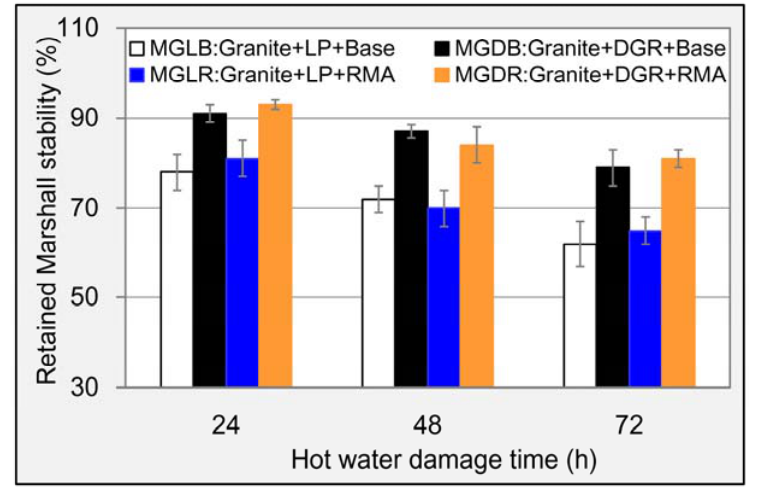
Figure 13. RMS results of different asphalt mixtures.